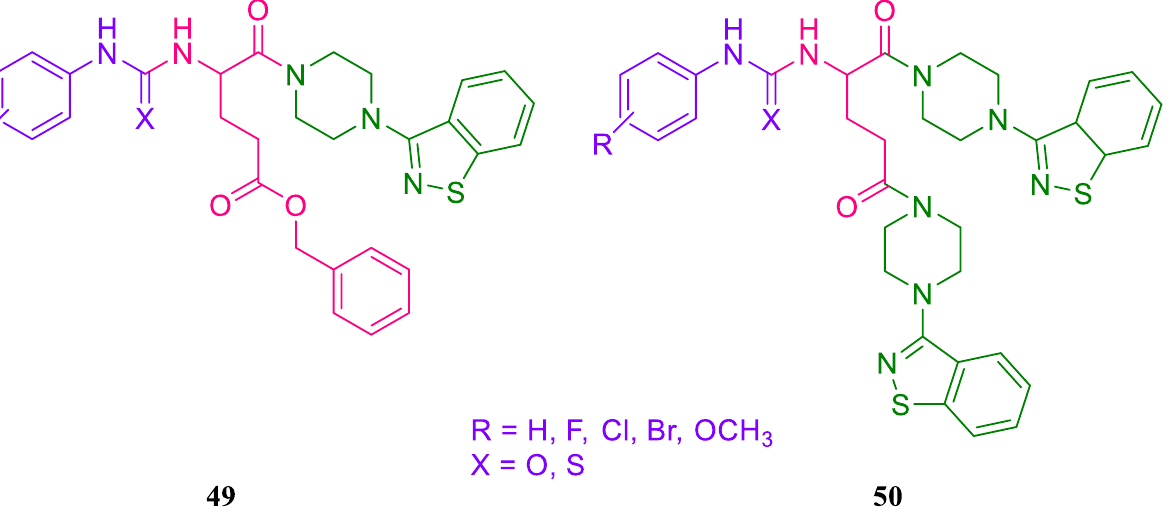
Figure 45. Glu conjugated to 3-(1-piperazinyl)-1,2-benzisothiazole. Suhas R et al. synthesised a series of quinazolinone-conjugated shorter analogues ( 51 ) of Bactenecin 7 (Bac7) peptides (RP, PRP, GPRP and RPRP). Bac7, a cathelicidin-derived peptide of bovine neutrophil granules having antimicrobial properties has 59 amino acids with three tandem repeats of a tetra decamers, consisting several PRP triplets and single hydrophobic amino acid (Figure 46). Therefore, the authors have chosen highly active tetrapeptides (GPRP and RPRP) from their earlier work [134], conjugated them to quinazoli- none moiety and examined the antimicrobial activity. The results reported that tetrapeptide analogues showed a higher potent activity than their tri- and dipeptide analogues. The authors examined antimicrobial activity of peptides alone, heterocyclic conjugates and the hydrogenolysed conjugates against a panel of pathogens. The results showed that all the conjugates have shown a more superior activity than the starting com- pounds. The hydrogenolysed tetrapeptide conjugates exhibited almost three to four folds more activity than the standard drugs used. In vitro antibacterial activity was tested against pathogens of both Gram-positive organisms, such as K. pneumoniae and P. putid a, and Gram-negative organisms, such as S . faecalis , S. pyogenes and E. coli , by agar-well dif- fusion and microdilution method. The antifungal activity was examined against A. flavus , C. capsisi , F. oxysporum , F. verticellartar and A. alternata by using the above methods. The activities of the compounds were dependent on the charge, hydrophobicity and length of the peptide chain. It was observed that, as the length of the peptide chain increased, ac- tivity also increased. The conjugates having RP, PRP, GPRP and RPRP exhibited zone of inhibition of 6 ± 0.36 mm to 31 ± 0.32 mm. The tetrapeptide, RPRP (MIC, IC 50 = 4 µg/mL) showed a small increase in activity than the GPRP (MIC, IC 50 = 5 µg/mL) conjugate, which may be due to the basic nature of Arg and also the bulky guanidine group. When the nitro group and benzyl ester at the C-terminus of the conjugates were removed, all the free- acid-containing compounds exerted high potency, nearly 3 – 4 times in stopping the growth of microbes. Thus, the quinozolinone conjugated with shorter peptides of Bac7, which are of small size, are easy to prepare, are of simple amino acid composition, of high antimicrobial activity and of low toxicity, making them highly active for the design of pharmaceuticals and the systematic treatment of the antibiotic-resistant strains of fungi and bacteria [135].